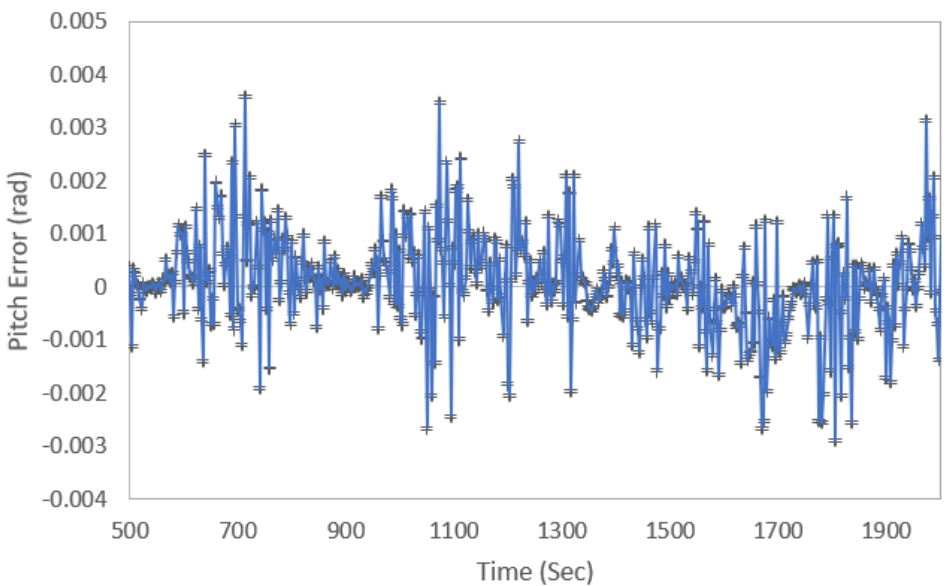
Figure 16. Pitch response error between ANN and FEM model results for wave height of 9.65 m and wave period of 9.94 s.